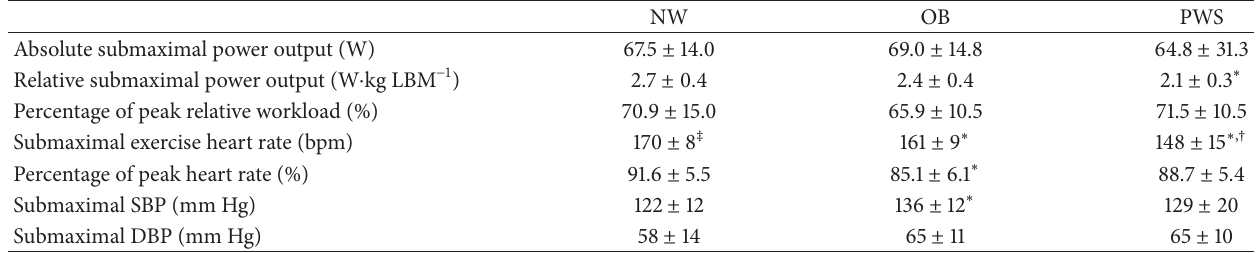
Table 3: Responses to submaximal intensity exercise, presented as mean ± SD.